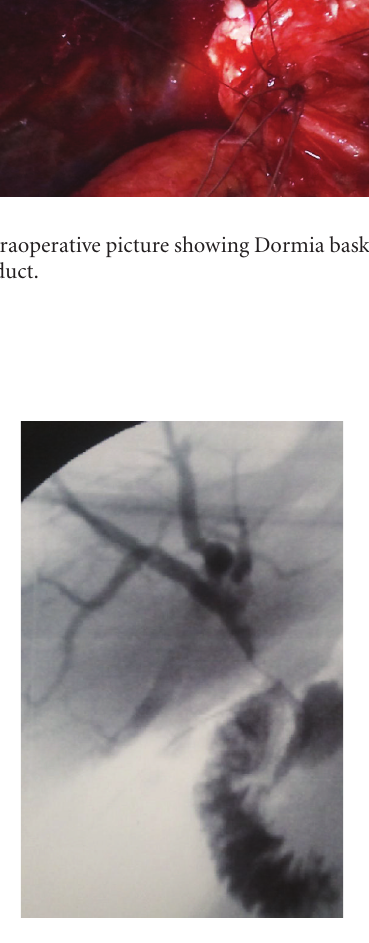
Figure 2: Trans-kher cholangiography at the end of the surgical procedure: no evidence of any filling defects in the biliary tree and good passage of the contrast medium into the